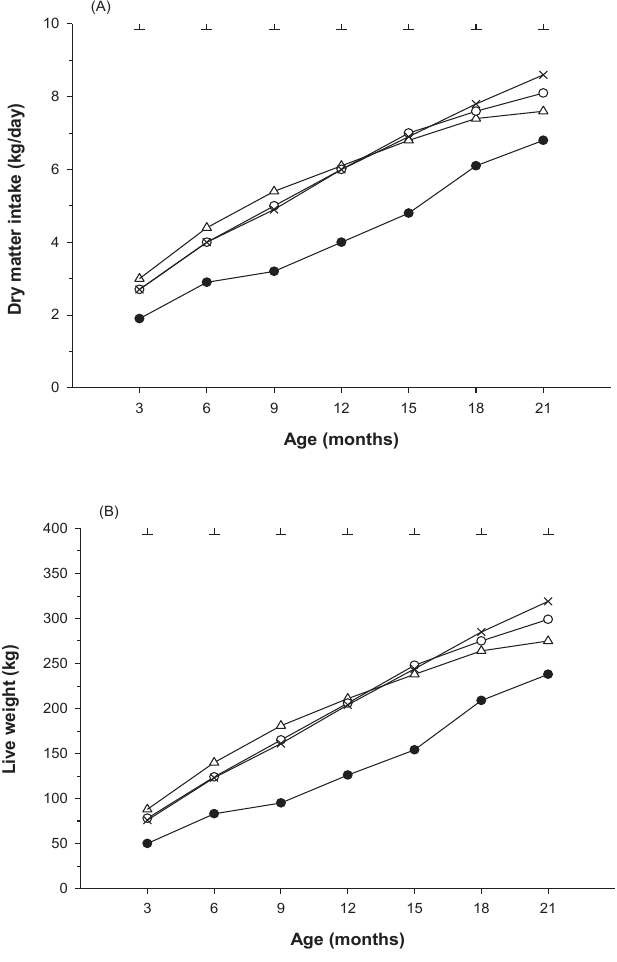
Figure 1. Dry matter intake (A) and body growth (B) of Local Yellow (Bos indicus)×Red Sindhi (Bos indicus; ● ), and crossbred 1/2 Limousin (LS; Δ), 1/2 Drought Master (DS; ○ ) and Red Angus (RS; ×) cattle in smallholder farming systems of the Central Highland region in Vietnam. Verticals bars represent pooled standard error.